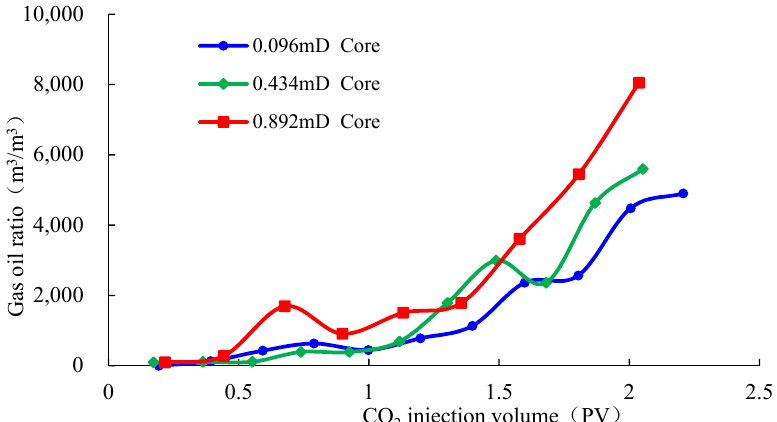
Figure 9. The gas–oil ratio of cores with different permeability under immiscible conditions.